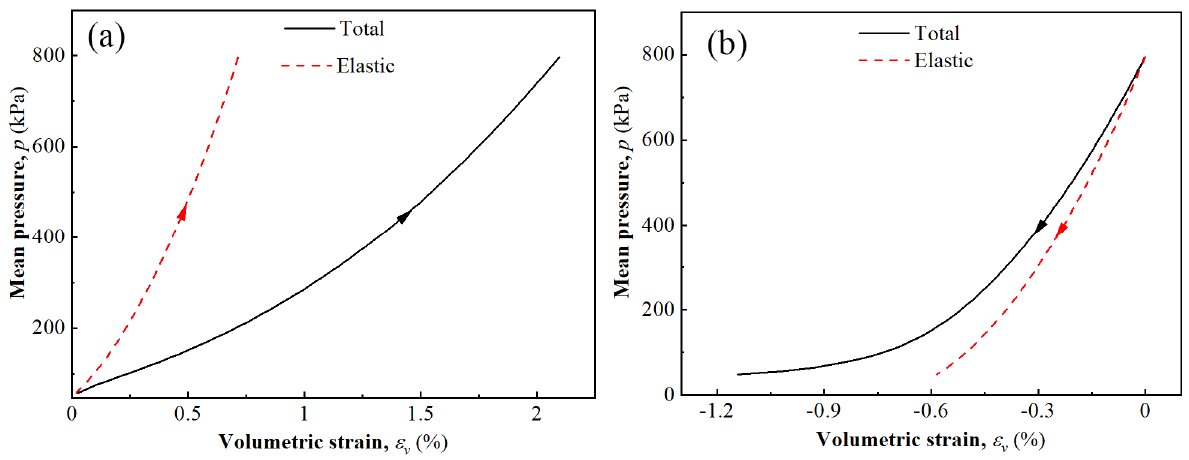
Figure 6. Sketch of the branches in mean pressure–volumetric strain curves in ( a ) reloading and ( b ) unloading in the CICT .